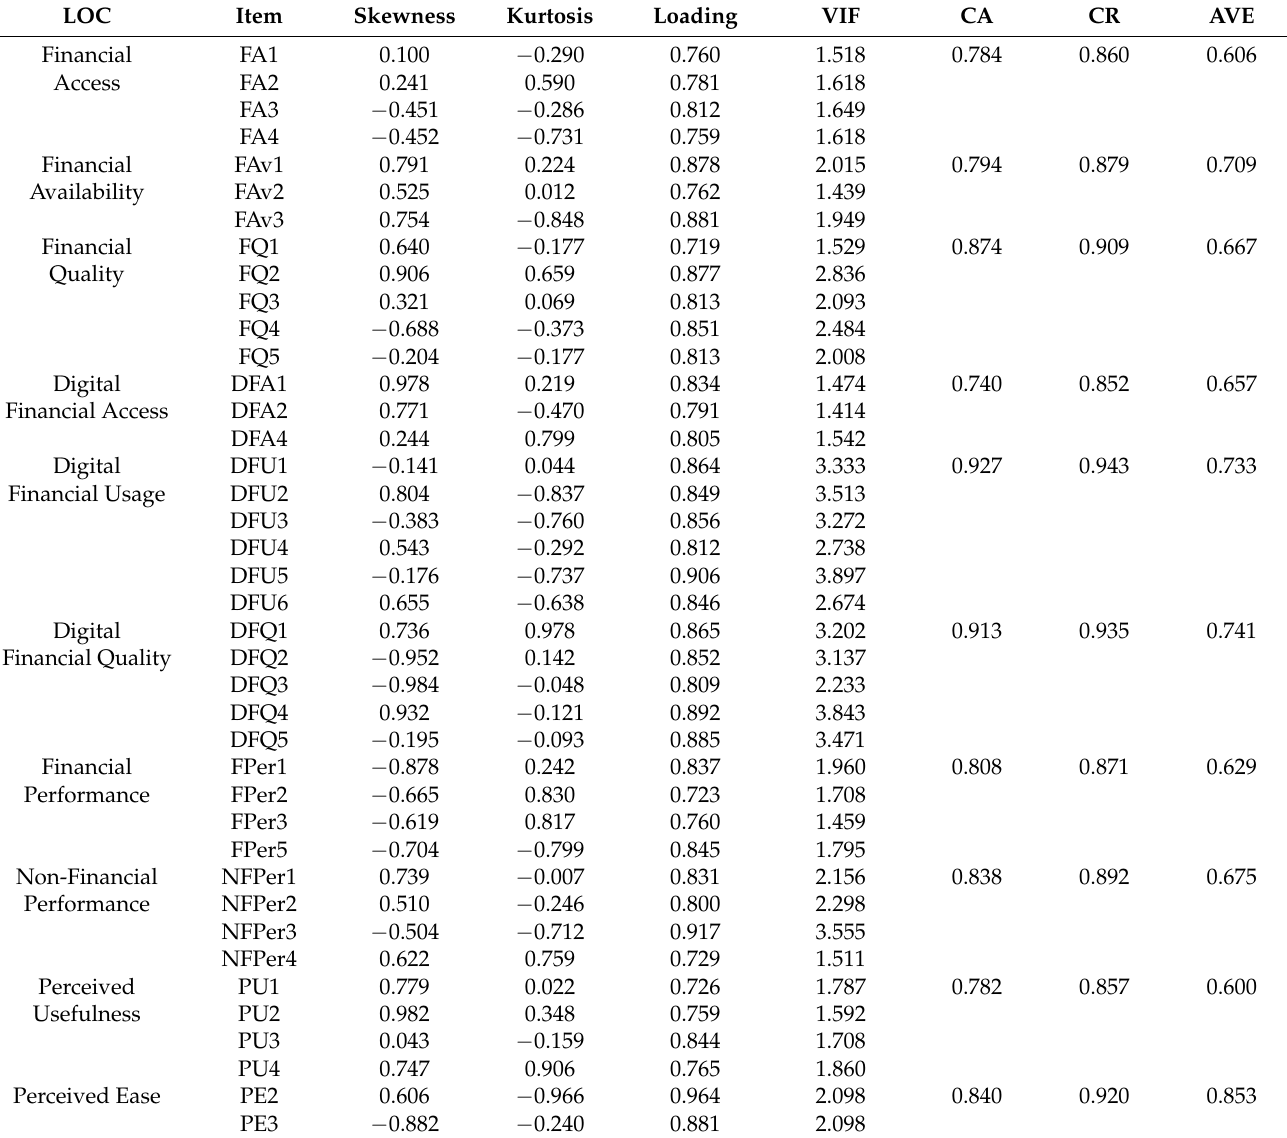
Table 3. Results of reliability, internal consistency, and convergent validity of